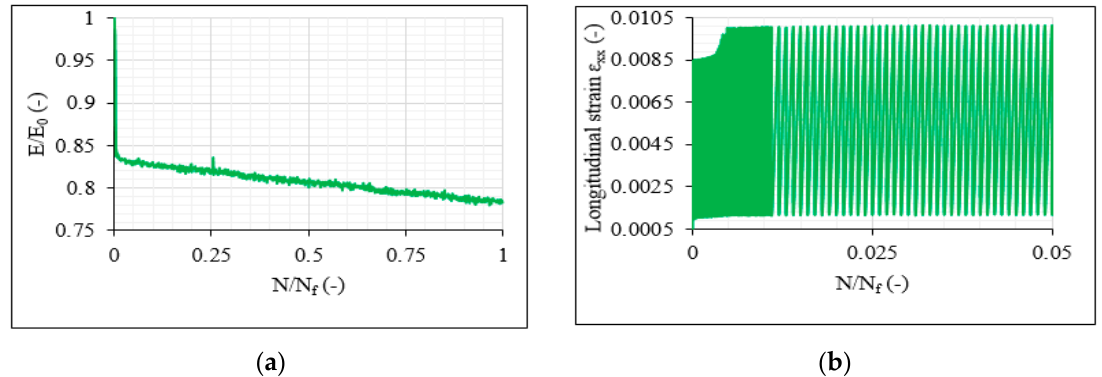
Figure 24. ( a ) Stiffness degradation versus the normalised fatigue life and ( b ) ε xx evolution during the 0–0.05 N/N f period for one [0°/30°/0°/ − 30°] s laminate for the 70%-0.1 test.